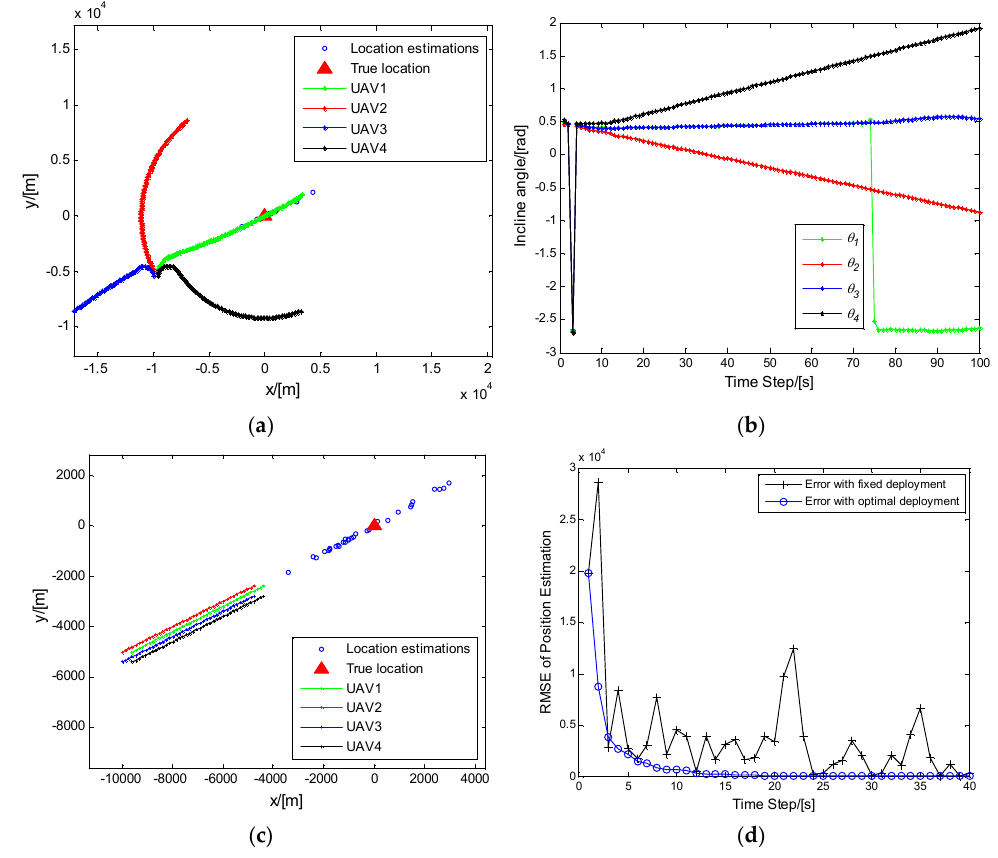
Figure 4. ( a ) Optimal paths without constraints. ( b ) Evolution of angle changes. ( c ) Straight-line paths. ( d ) Comparison of localization performance: optimal deployment and fixed deployment.